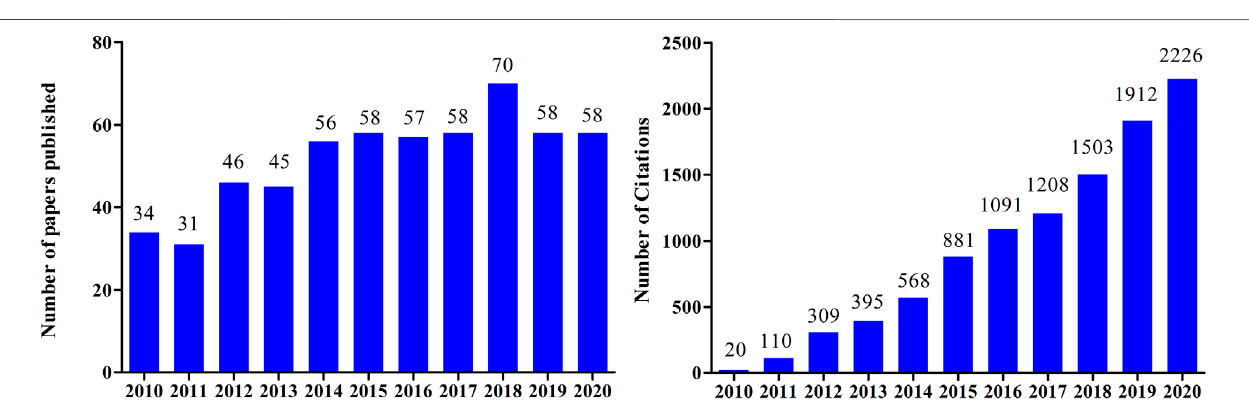
FIGURE2|(A) Numberofpaperspublishedbetween2010and 2020containingthekeyword “ tanshinoneI ” ,searchedaccordingtoWebofScience. (B) Citations between 2010 and 2020 using the keyword “ tanshinone I ” , searched according to Web of Science.